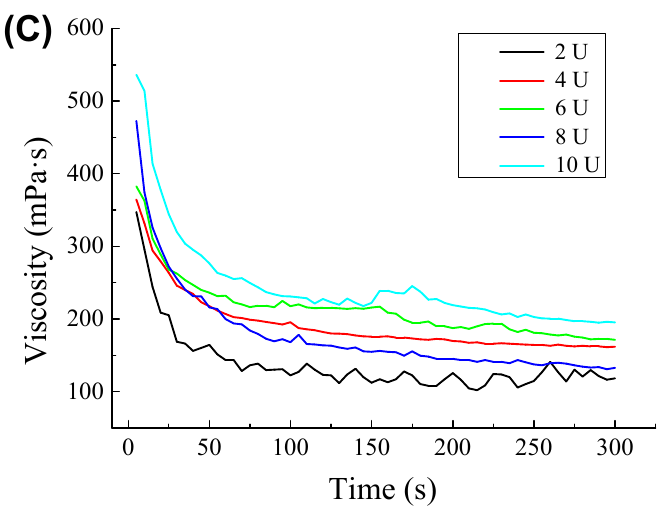
Figure 5. Change over time in viscosity of ( A ) primary emulsions (protein content was 0.8 g/100 g, 1.8 g/100 g, 2.8 g/100 g, 3.8 g/100 g, and 4.8 g/100 g); ( B ) secondary emulsions (protein content was 3.8 g/100 g, and SBP content was 0.01 g/100 g, 0.02 g/100 g, 0.05 g/100 g, 0.10 g/100 g, and 0.15 g/100